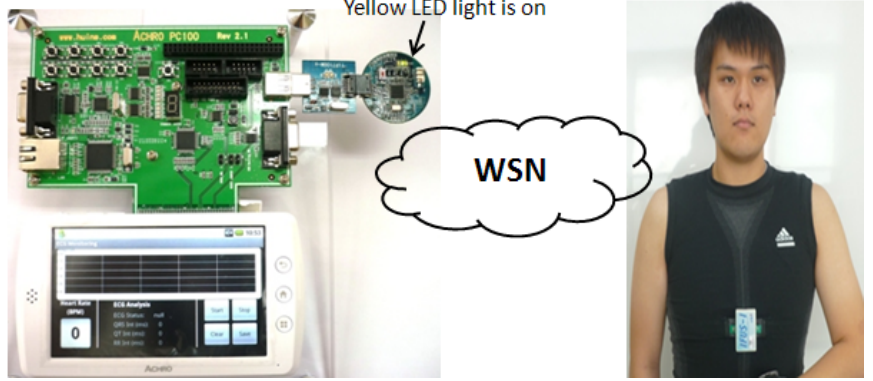
Figure 12. Setup of ECG real time monitoring